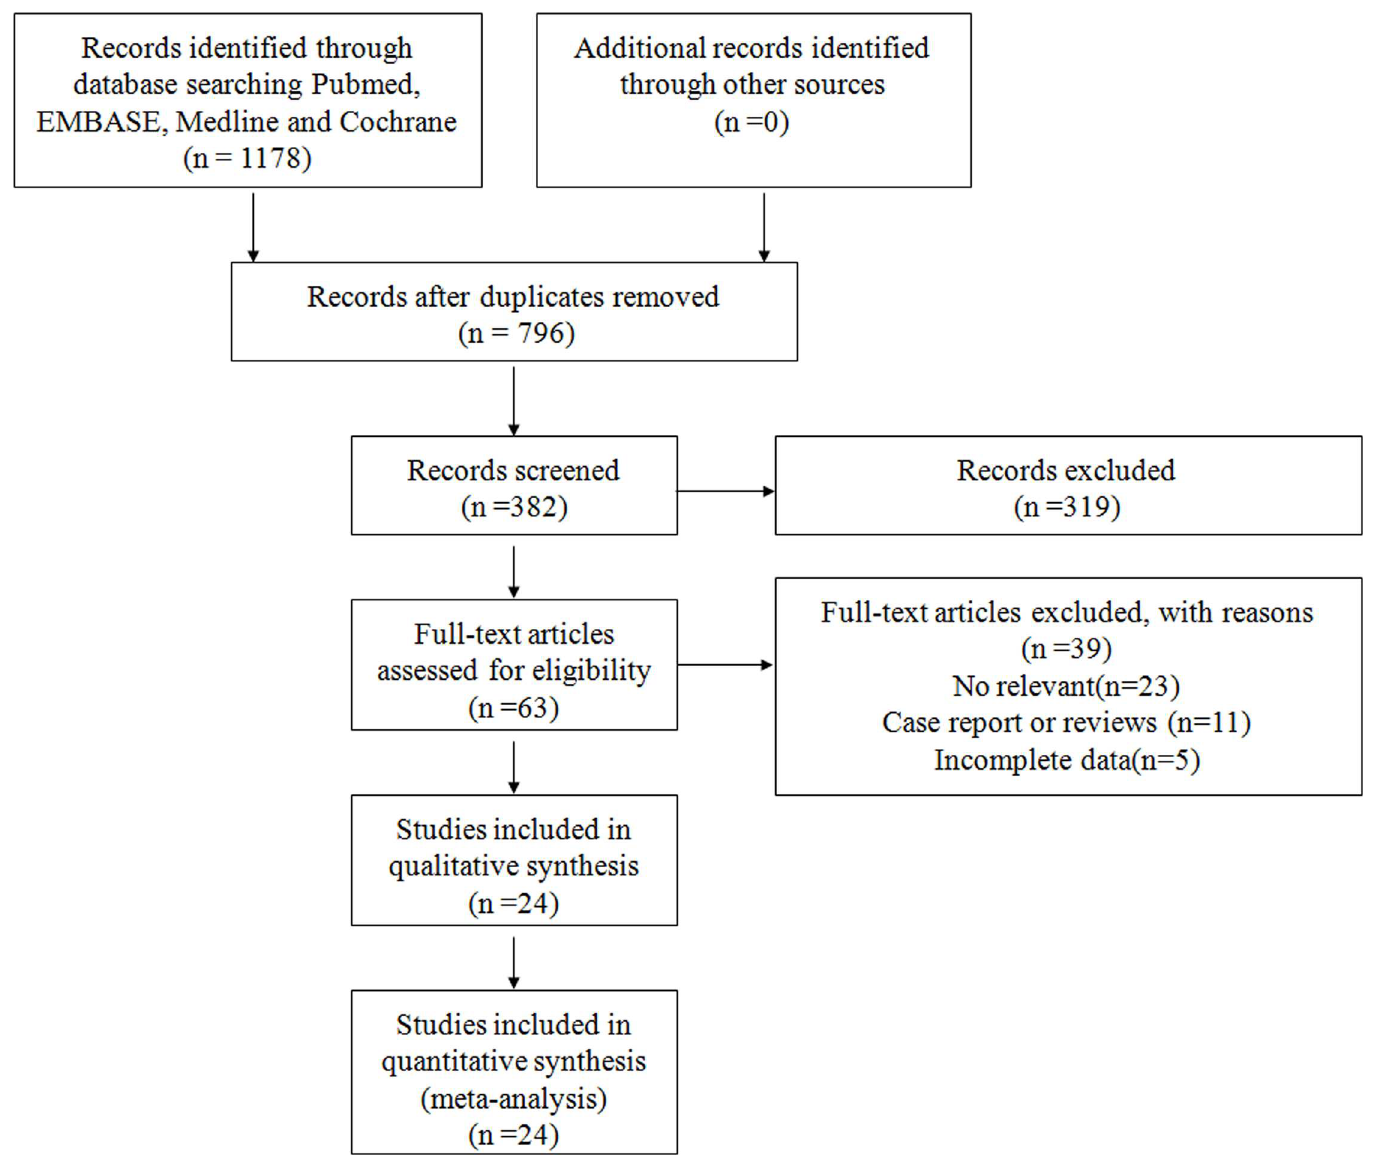
Fig 1. Study flow for the